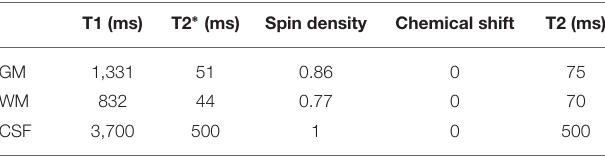
TABLE 3 | A list of MR parameters (relaxation times T1, T2 ∗ , spin density, and chemical shift value) used in our simulations within